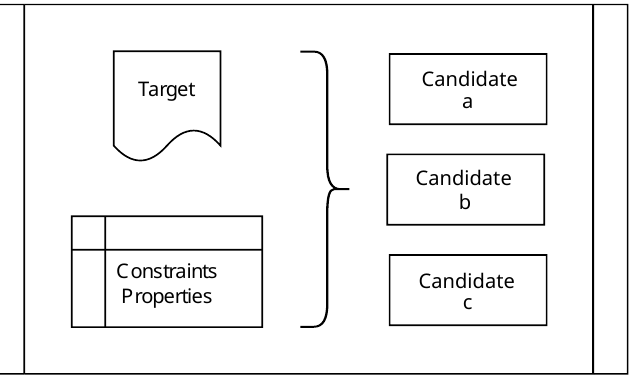
Figure 2. Single hierarchical step representing an optimisation problem. Multiple candidate solutions can be generated, which may be used in succeeding